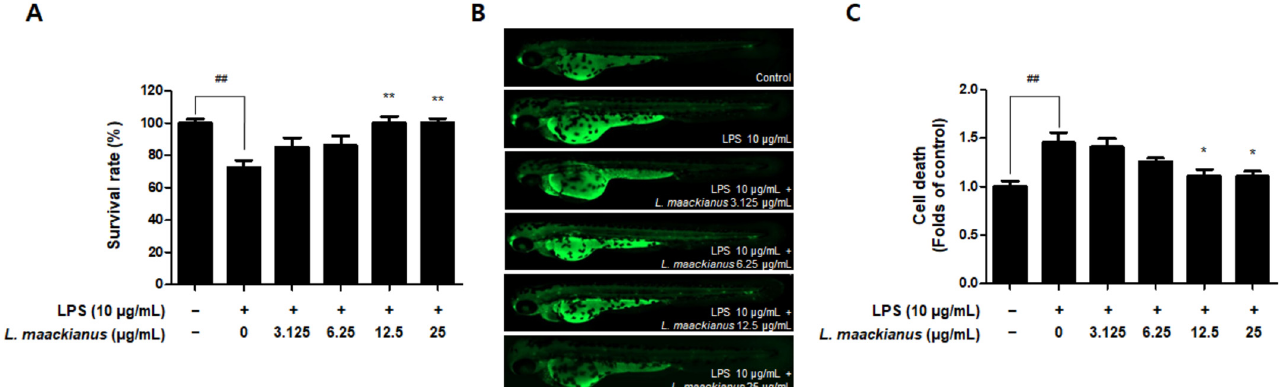
Figure 9. Anti-inflammatory ( A ) and cytoprotective effect ( B , C ) of L. maackianus (MeOH) extract in LPS-treated zebrafish model. Measurement results after 7 d treatment with 10 µ g/mL LPS and extract (3.125–25 µ g/mL). Data are presented as the mean ± standard deviation for three independent experiments. Unprocessed control groups were included. ## p < 0.01 compared to control. * p < 0.05, ** p < 0.01 compared to LPS-treated